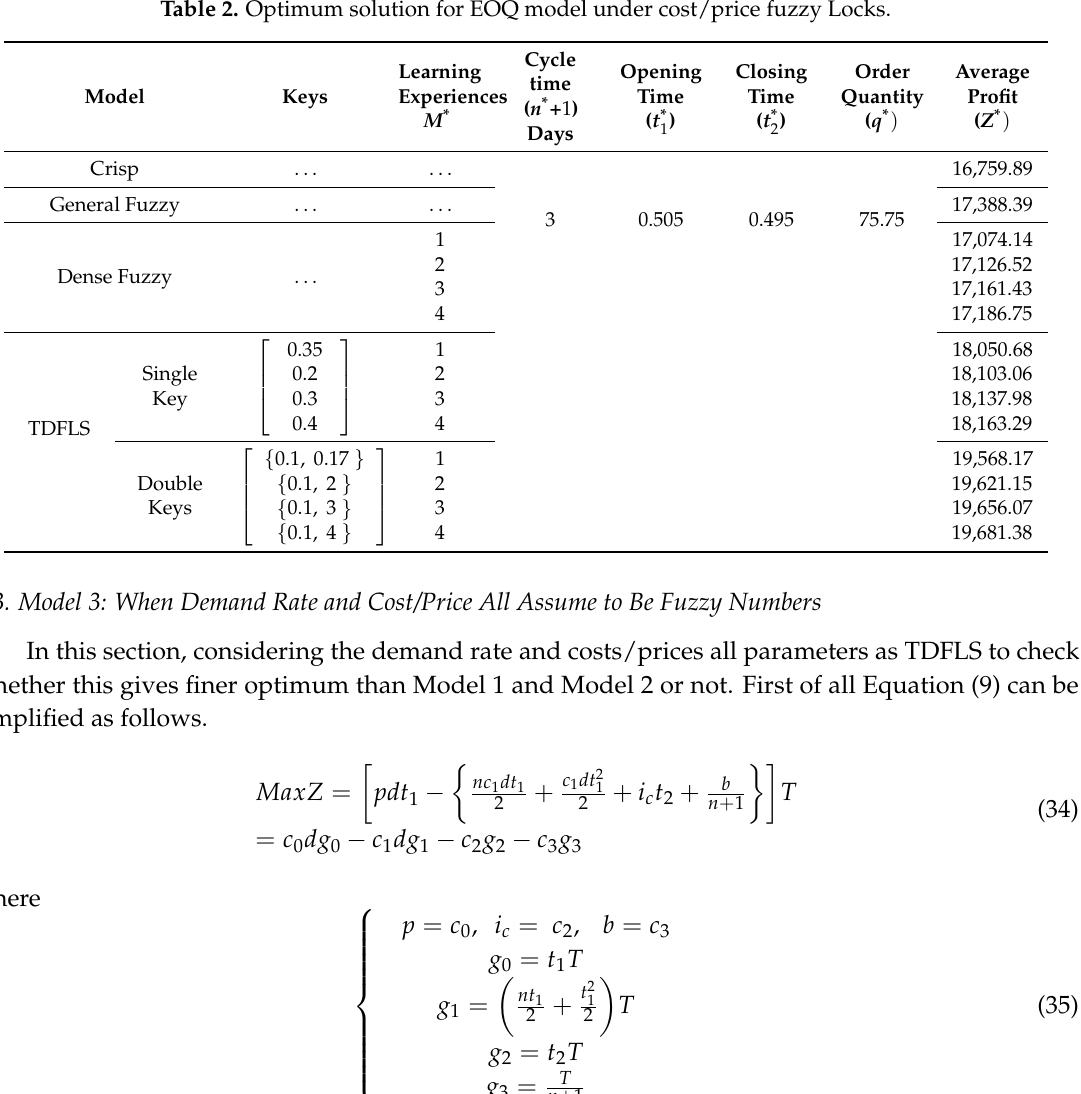
Table 2. Optimum solution for EOQ model under cost/price fuzzy